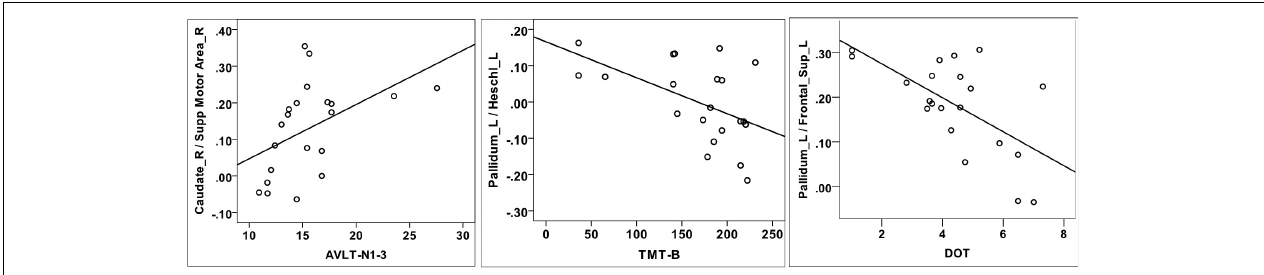
FIGURE 3 | Correlation analysis between decreased FCs and cognitive tests. AVLT-N1-3 scores were positively correlated with FCs between right caudate and right supplementary motor area (A) . TMT-B scores were negatively correlated with FCs between left pallidum and left Heschl’s gyrus (B) . DOT scores were negatively correlated with FCs between left pallidum and left superior frontal gyrus (C)